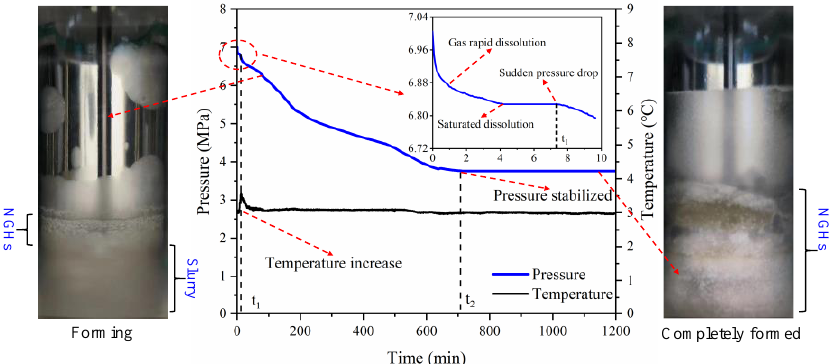
Figure 3. Temperature and pressure curves and experimental phenomena at key time spots during hydrate formation in 1.0 wt% sediment solutions.